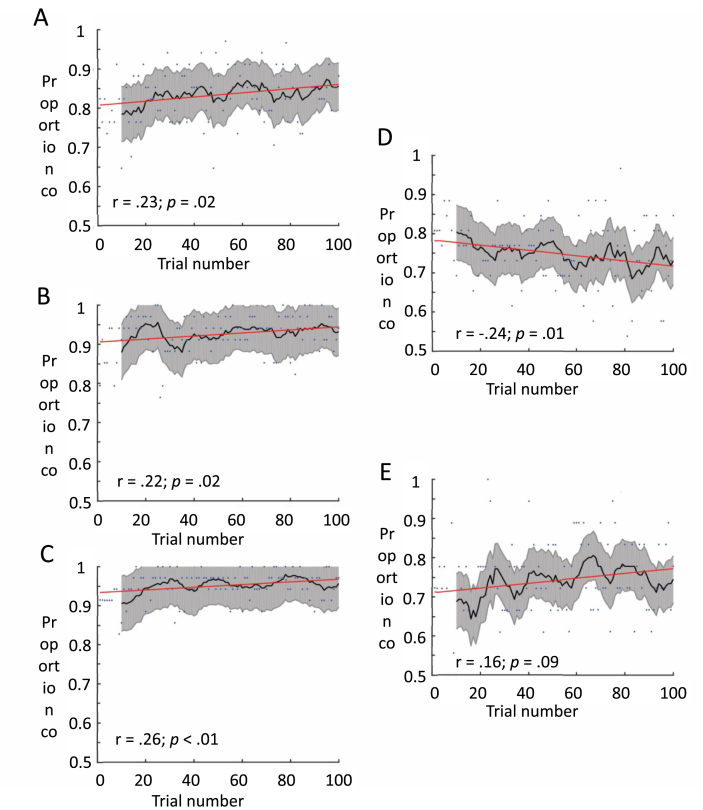
Course of change in performance (mean accuracy) over time on task. Blue dots represent group mean accuracy on each trial. Red lines represent the linear fit. Black lines represent the moving average window, averaging performance over ten trials at each point. Shaded grey colours represent the standard error of the average moving window. Pearson's Rho values and their associated p-vales appear on each figure. Groups: A) young neurotypical; B) Mid Neurotypical; C) Older Neurotypical; D) Children with Williams syndrome; E) Children with Down's syndrome. (For interpretation of the references to colour in this figure legend, the reader is referred to the Web version of this article.)